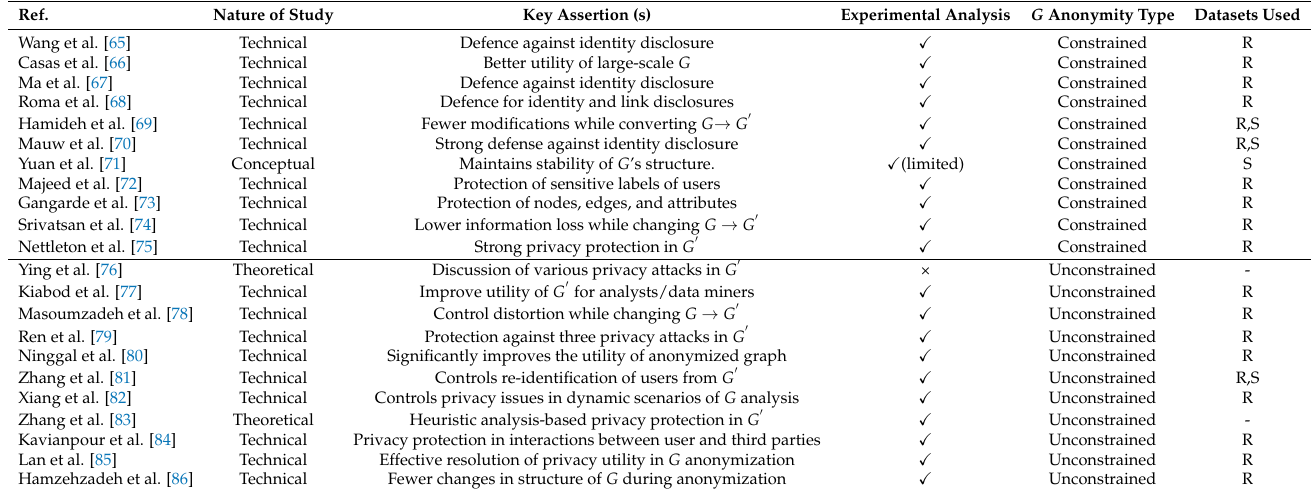
Table 3. Summary and comparison of state-of-the-art graph modification-based techniques.